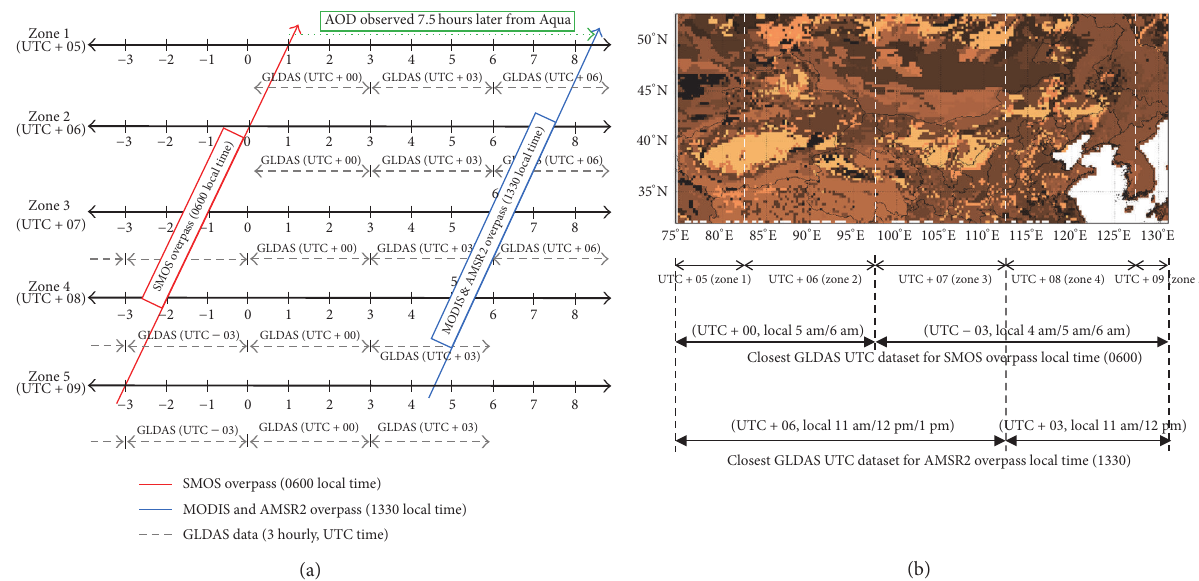
Figure 2: A graphical representation of the methodology for matching GLDAS UTC zone based products with local overpass times of SMOS, AMSR2, and MODIS in different time zones within the study area.